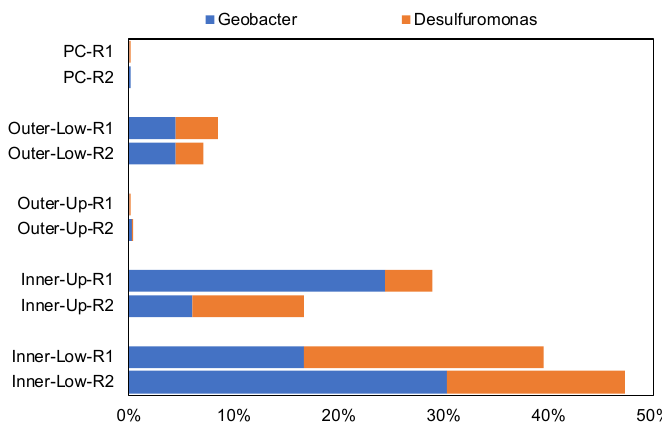
Figure 6. Relative abundances of exoelectrogenic bacteria (at the genus level) in the bioelectrochemical system-trickling filter (BES-TF) reactors R1 and R2. PC: planktonic cells, Outer-Low: Outer biofilm of the lower part of the anode (submerged in wastewater), Outer-Up: Outer biofilm of the upper part of the anode (not submerged in the wastewater), Inner-Low: Inner biofilm of the lower part of the anode (submerged in wastewater), Inner-Up: Inner biofilm of the upper part of the anode (not submerged in the wastewater).